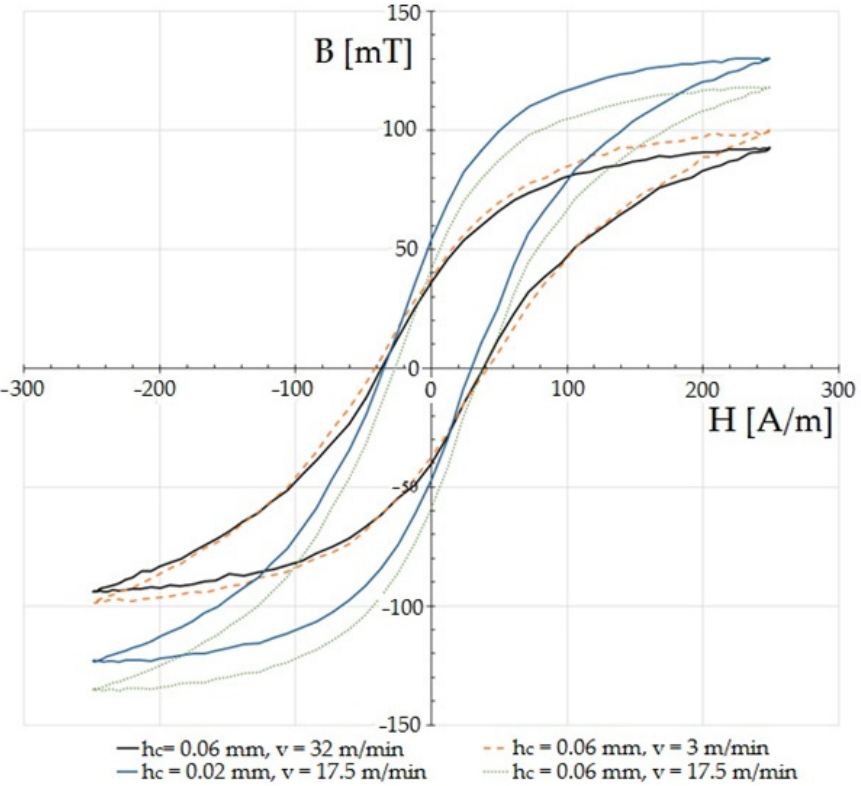
Figure 16. Influence of selected values of input factors of the cutting process on the magnetic characteristics B (H) of the ET 110-30LS sheet.